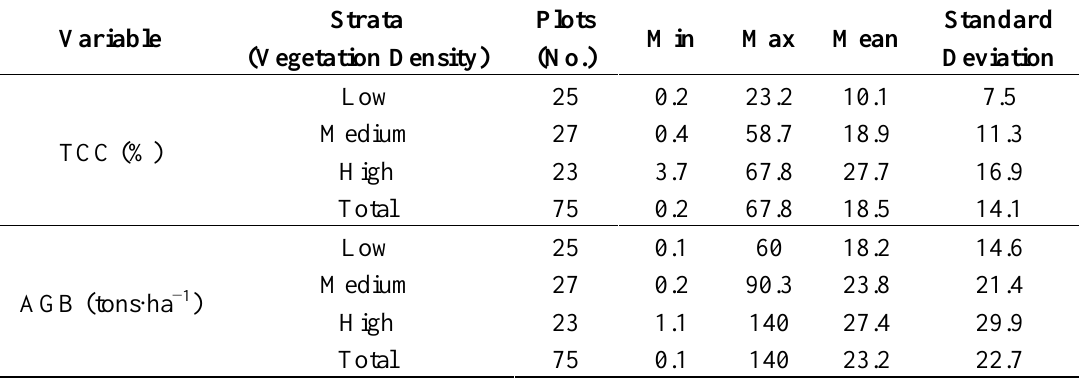
Table 1. Details of the field data showing plot level information for tree canopy cover (TCC) and aboveground biomass